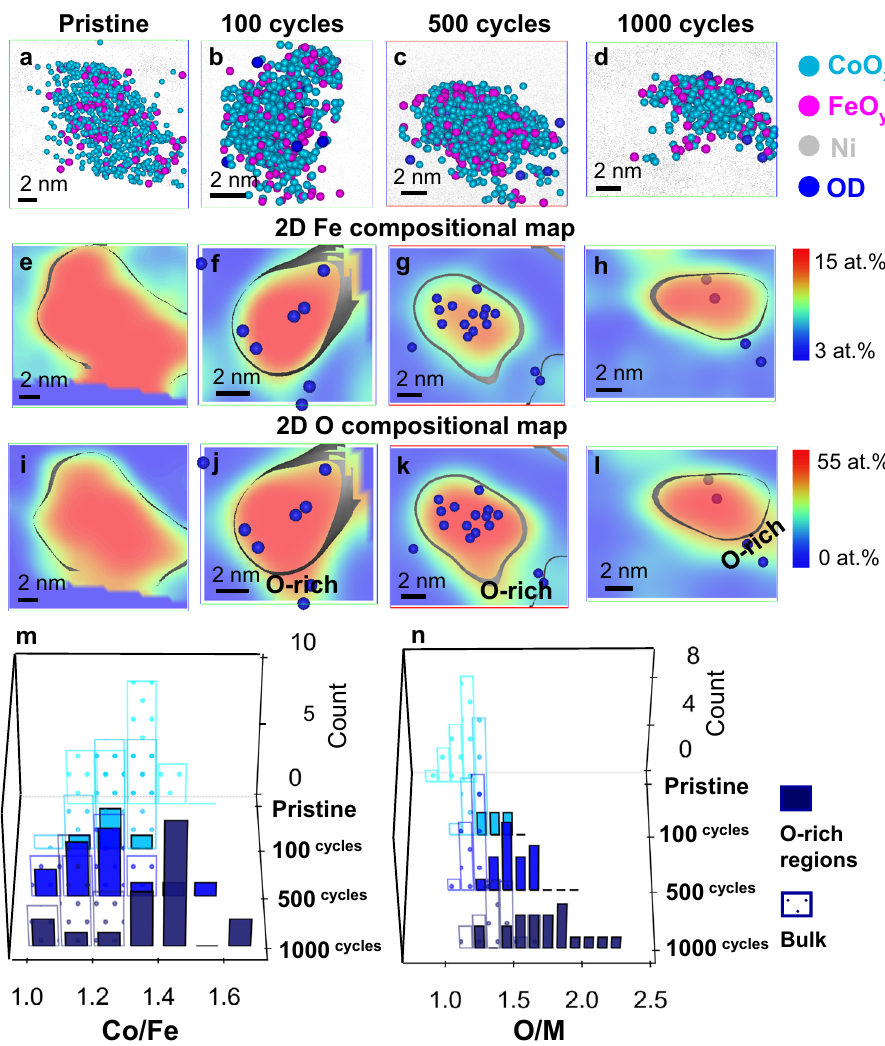
Fig. 5 Compositional evolution and elemental distribution of non-segregated Co 2 FeO 4 during OER. a – d 3D atom maps, 2D compositional maps of e – h Fe and i – l O of non-segregated Co 2 FeO 4 nanoparticles in the pristine state and after 100, 500 and 1000 cycles, compositional histograms of m Co/Fe ratios and n O/M ratios (M = Co + Fe) in the O-rich nanoregions and the bulk part of non-segregated Co 2 FeO 4 nanoparticles in Fig. 4a – d and Supplementary Fig. 12a – d. (Source data of Fig. 5m, n are provided as a Source Data fi